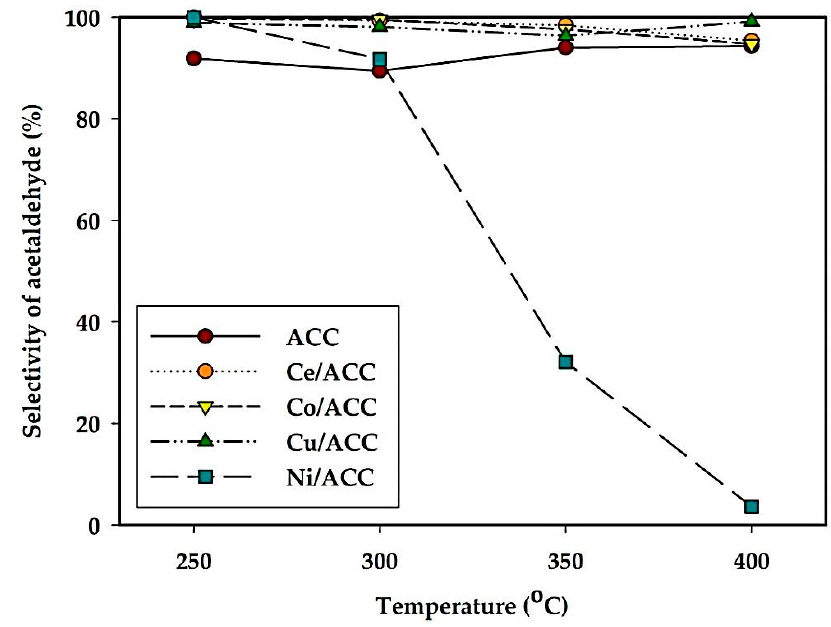
Figure 7. Selectivity of acetaldehyde of catalysts.